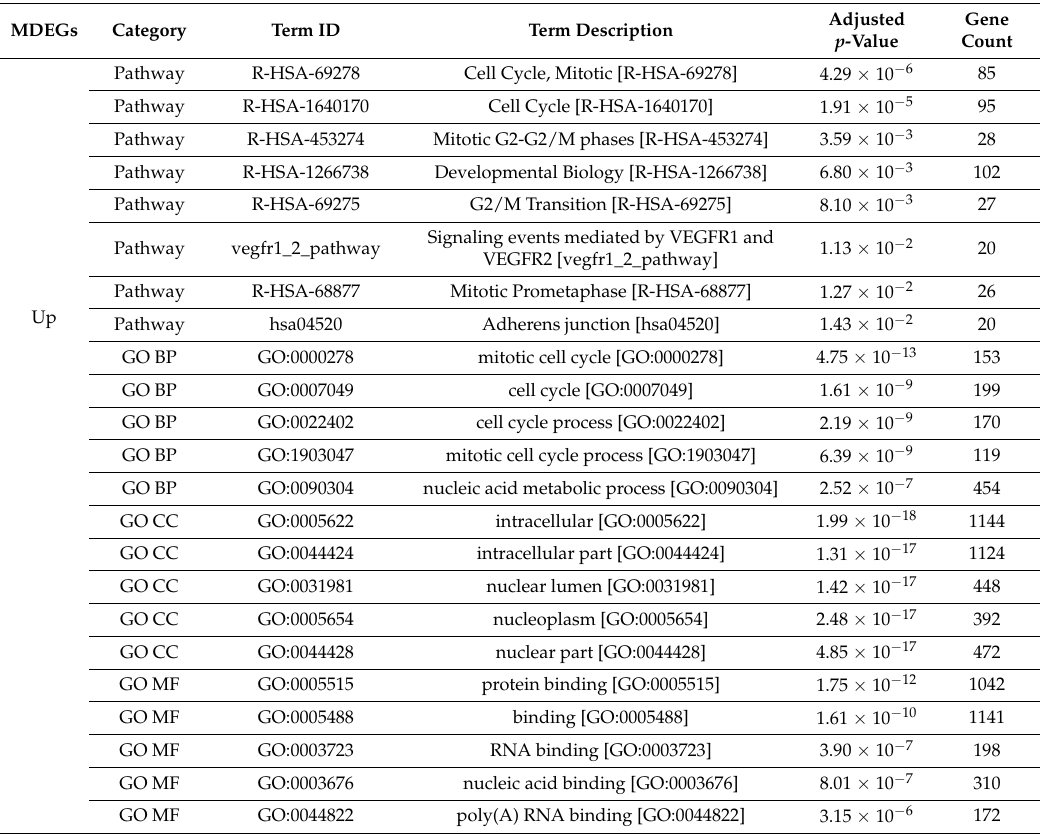
Table 2. Pathways (all) and functions (top 5) enriched by